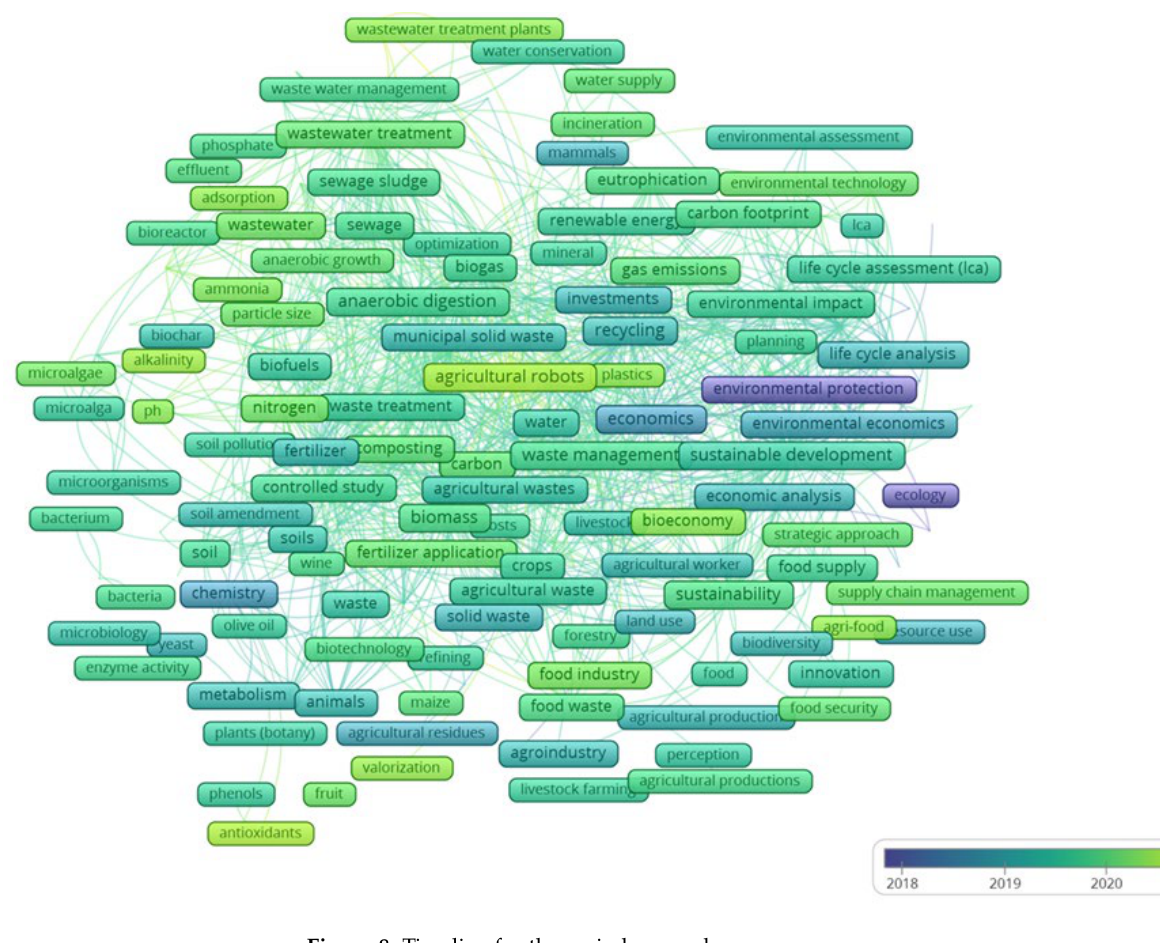
Figure 8. Timeline for the main keywords.